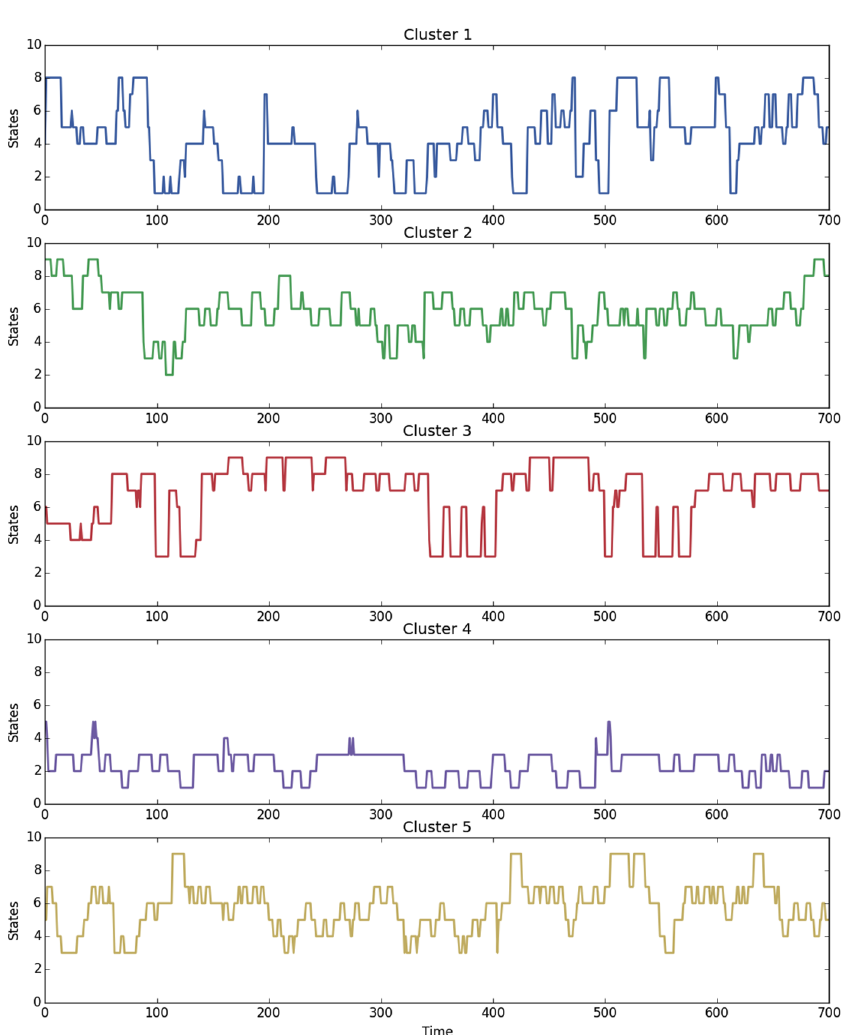
Fig 10. Comparison Of Simulated States Sequences By Cluster. Simulated Clusters show clear States differences consistent with the realized